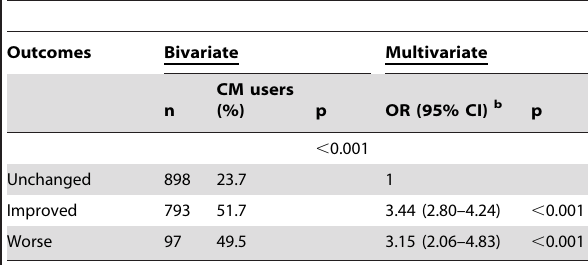
Table 2. Bivariate and multivariate associations between clinical outcomes and CM use in patients with schizophrenia. a